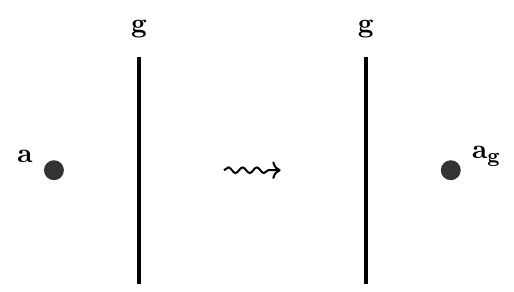
Figure 2 . One can visualize the action of the g -defect on the point operator by the defect wrapping the operator as it passes